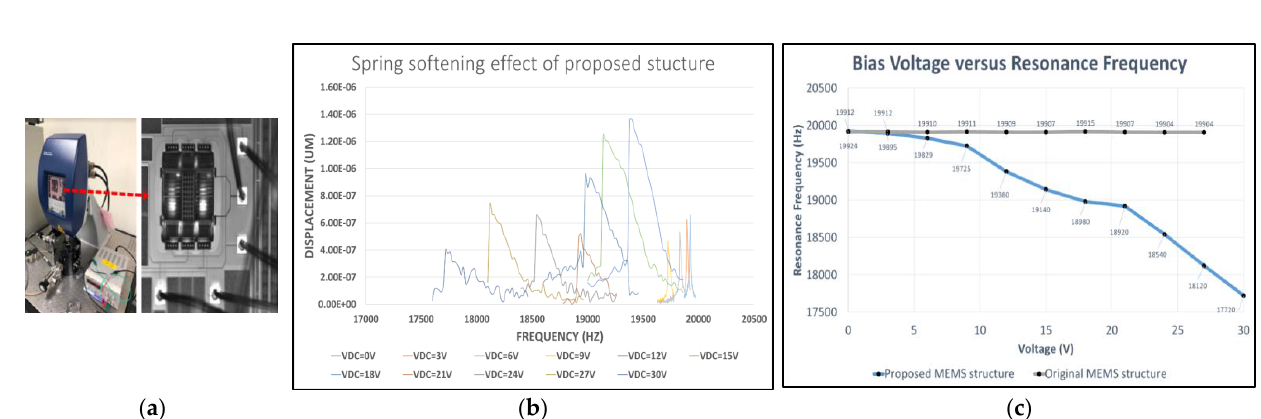
Figure 15. (a) Measurement setup of spring softening effect; (b) spring softening effect of proposed structure; (c) Figure 15. ( a ) Measurement setup of spring softening effect; ( b ) spring softening effect of proposed structure; ( c ) com-parison